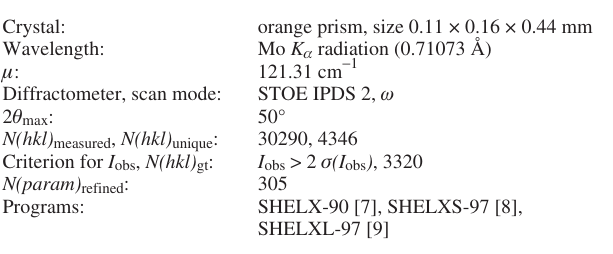
Table 1. Data collection and